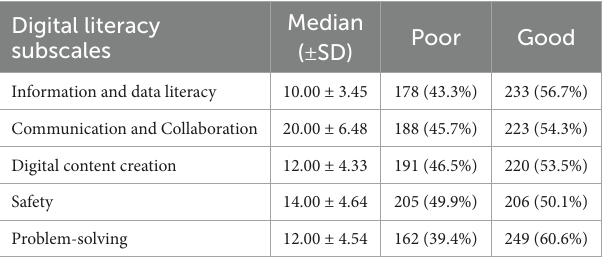
TABLE 4 Components of health professionals’ digital